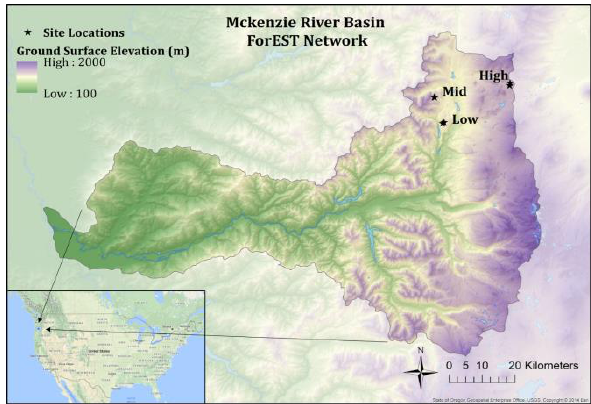
Figure 1. The Oregon ForEST network sites of the McKenzie River